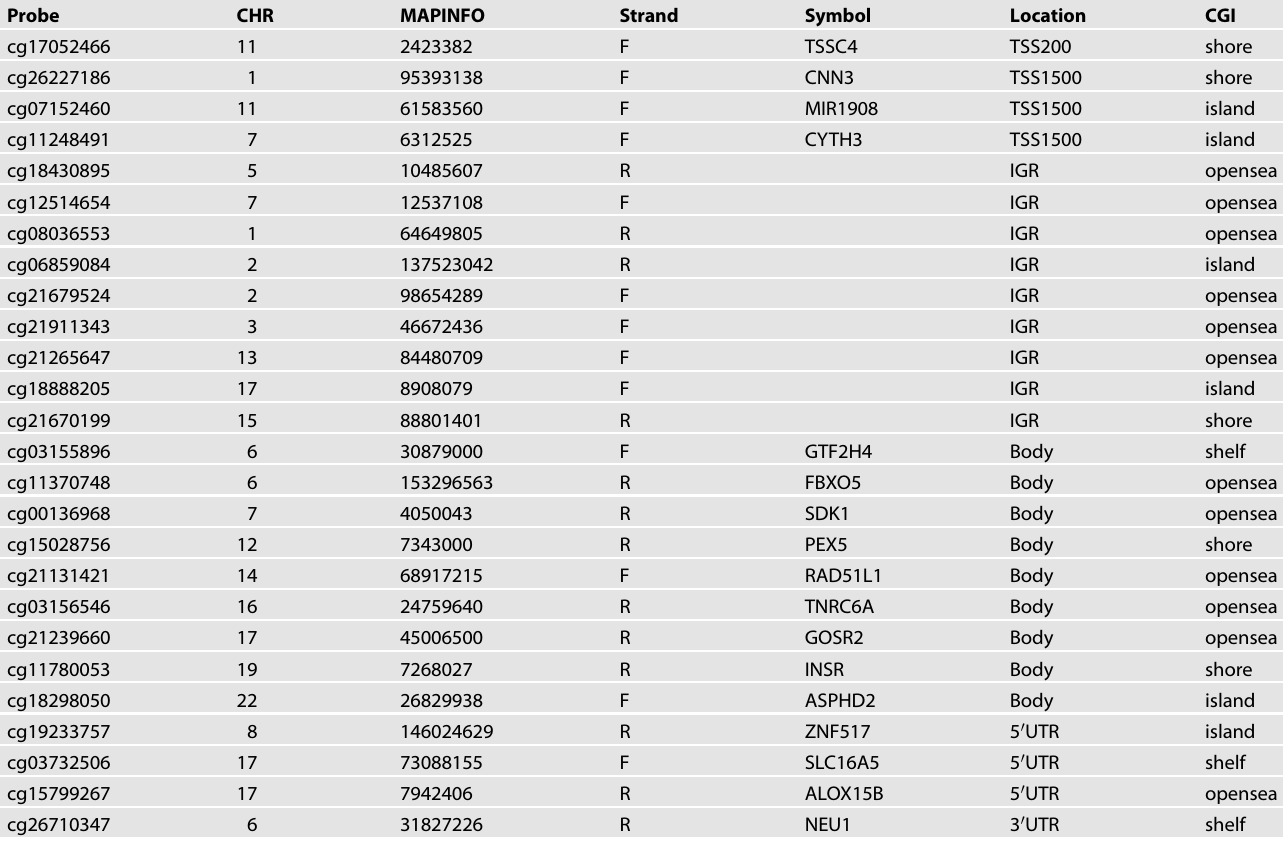
Table 2. Putative markers predict treatment